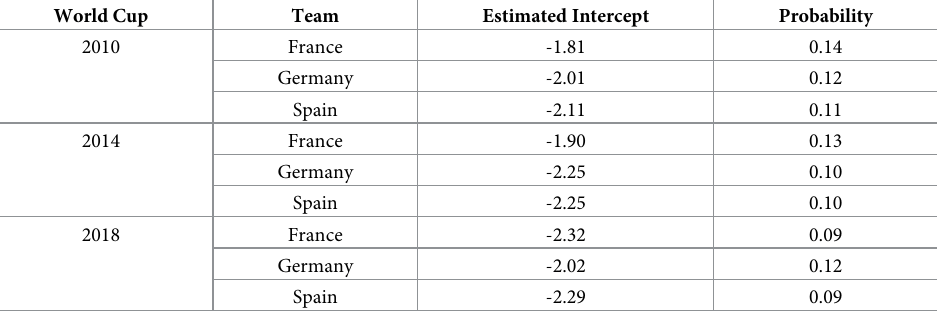
Table 2. Random effect estimated log odds intercepts and base probabilities for possessions that result in a shot for each team at the 2010, 2014 and 2018 World Cup